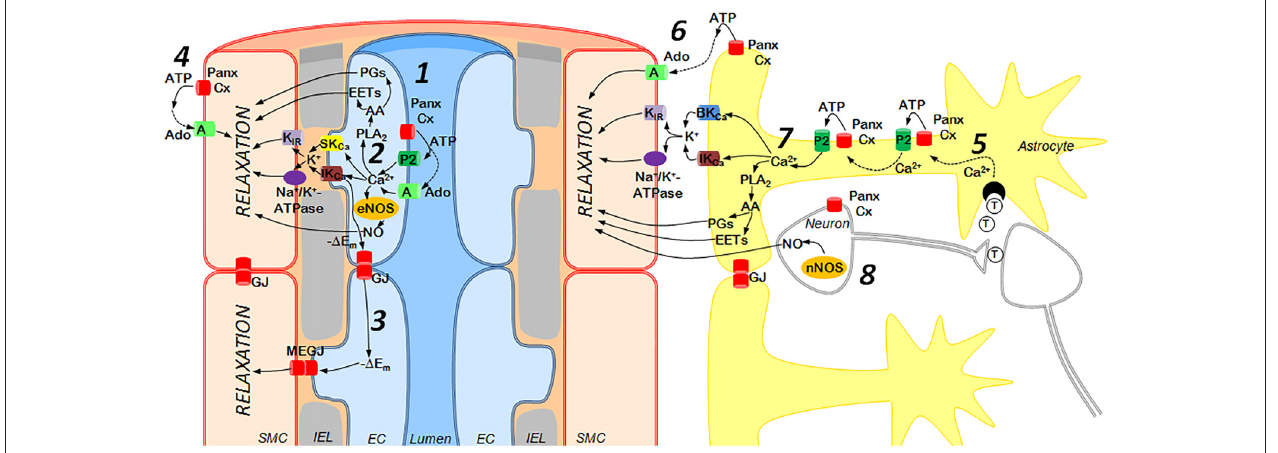
FIGURE 2 | Purinergic mechanisms of cerebrovascular dilation: the role of endothelium (left) and astrocytes/neurons (right). Left : ATP is released from activated endothelial cells (EC) via Panx or Connexin (Cx) hemichannels and activates P2 receptors (subtypes P2Y1, P2Y2, P2Y4, P2Y6 and P2X4) or may be cleaved by ectonucleotidases to adenosine (Ado), an agonist of A receptors (subtypes A 2a , A 2b ) (1). This elevates Ca 2 + concentrations in EC and activates numerous mechanisms of vasorelaxation including (2): (i) SK Ca and IK Ca channel opening followed by the outward K + current, activation of smooth muscle cell (SMC) K IR channels and Na + /K + -ATPase and hyperpolarization of SMC (the endothelium-derived hyperpolarization (EDH) mechanism); (ii) phospholipase A2 (PLA 2 ) activation, resulting in synthesis of vasodilators from arachidonic acid (AA); (iii) endothelial nitric oxide synthase (eNOS) activation followed by NO release. Hyperpolarization may spread along the endothelium via Panx or Cx gap junctions (GJ) and also may enter SMCs via myoendothelial gap junctions (MEGJ), formed by Panx or Cx (3). In addition, ATP released from SMCs may be cleaved to Ado, causing vasodilation via activation of A 2 receptors (4). Right : Astrocytes in close proximity to interneuronal synapses can be activated by neurotransmitters (T), such as glutamate and ATP (5), leading to a rise in astrocytic Ca 2 + concentrations, ATP release via Panx or Cx hemichannels, activation of P2 receptors and generation of Ca 2 + -waves (5). ATP released from astrocytes may be rapidly degraded to Ado, which relaxes SMCs through A receptors (6). In the astrocytic endfeet, increased Ca 2 + concentrations may activate (7): (i) BK Ca and IK Ca channels followed by the outward K + current, hyperpolarization (via K IR and Na + /K + -ATPase) and relaxation of SMC; (ii) PLA 2 resulting in synthesis of vasodilators from AA. In addition, neuronal NOS (nNOS) may produce NO (8). EC and astrocytes/neurons regulate cerebrovascular tone using similar mechanisms, such as K + efflux through SK Ca /IK Ca or BK Ca /IK Ca channels followed by hyperpolarization and relaxation of arterial smooth muscle. Similarly, Prostaglandins (PGs) or epoxyeicosatrienoic acids (EETs) produced by either astrocytic or EC serve as vasodilators, as does NO derived from neurons or EC.